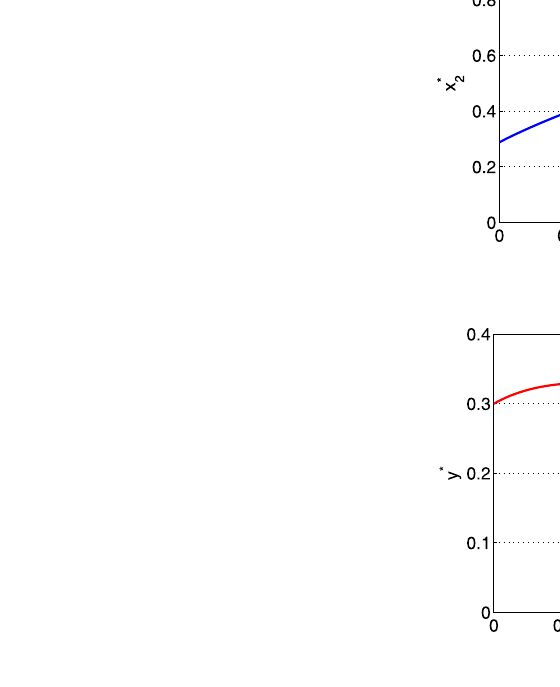
Figure 3 The relation curves of x ∗ 2 and y ∗ versus m . Here we fix τ = 2.5 and choose the other parameters from